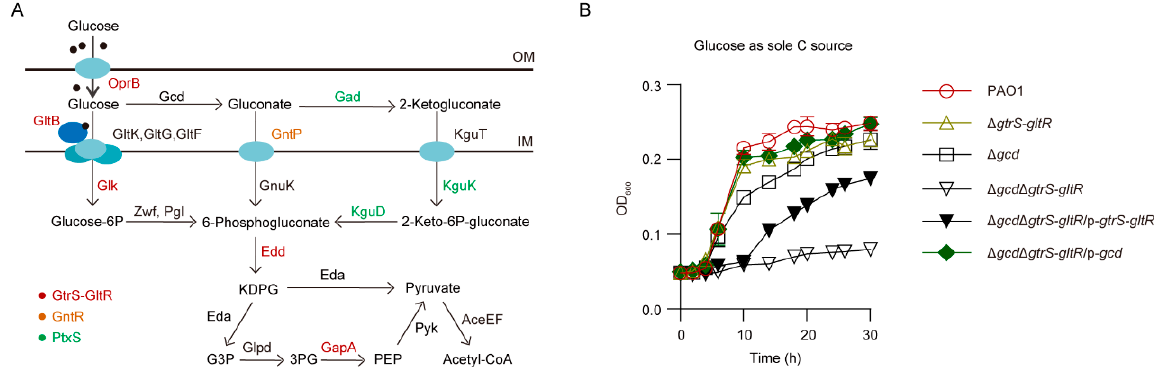
Figure 1. Proposal pathways of glucose metabolism and bacterial growth assays. ( A ) Schematic view of predicted glucose utilization and metabolism pathways in P. aeruginosa inferred from previous studies [23,51]. Proteins are shown in different colors according to the regulators (e.g., GtrS-GltR, GntR, and PtxS) that participate in their transcriptional regulation [25,26,52]. OM, outer membrane; IM, inner membrane; OprB, glucose porin; GltB, periplasmic glucose-binding protein [53–55]; GltK, ATP-binding component of ABC transporter; GltG and GltF, permease of ABC sugar transporter; GntP, gluconate permease; KguT, 2-ketogluconate (2-KG) transporter; Gcd, glucose dehydrogenase; Gad, gluconate dehydrogenase; Glk, glucokinase; GnuK, gluconokinase; KguK, 2-KG kinase; Zwf, glucose-6-phosphate 1-dehydrogenase; Pgl, 6-phosphogluconolactonase; KguD, 2-KG reductase; Edd, phosphogluconate dehydratase; Eda, 2-keto-3-deoxy gluconate aldolase; Glpd, glycerol-3-phosphate dehydrogenase; GapA, glyceraldehyde-3-phosphate dehydrogenase; Pyk, pyruvate kinase; AceEF, pyruvate dehydrogenase. KDPG, 2-keto-3-deoxy-6-phosphogluconate; G3P, glyceraldehyde-3P; 3PG, 3-phosphoglycerate; PEP, phosphoenolpyruvate. ( B ) The growth curve of P. aeruginosa strains cultured in 96-well plates containing minimal medium (MM) supplemented with 10 mM glucose as the sole carbon source. PAO1, ∆ gtrS-gltR , ∆ gcd , and ∆ gcd ∆ gtrS-gltR harbor an empty pAK1900 vector as control; p- gtrS-gltR denotes the pAK1900- gtrS-gltR plasmid; p- gcd denotes the pAK1900- gcd plasmid. OD 600 , an optical density at 600 nm. Data from n = 3 biological replicates reported as mean ± SD.